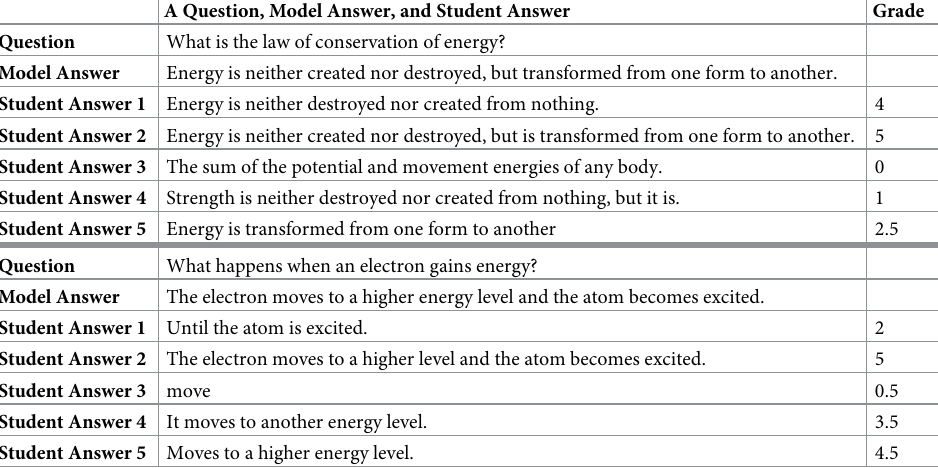
Table 3. An English translation of the previous Arabic